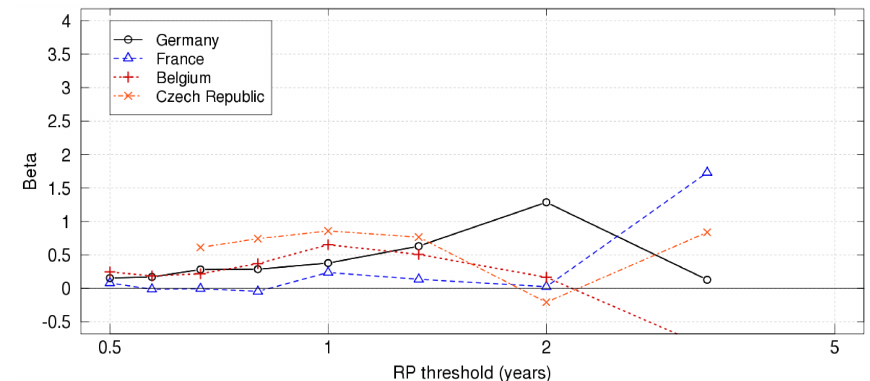
Figure 8. As Fig. 7b, with 1989/1990 storm season